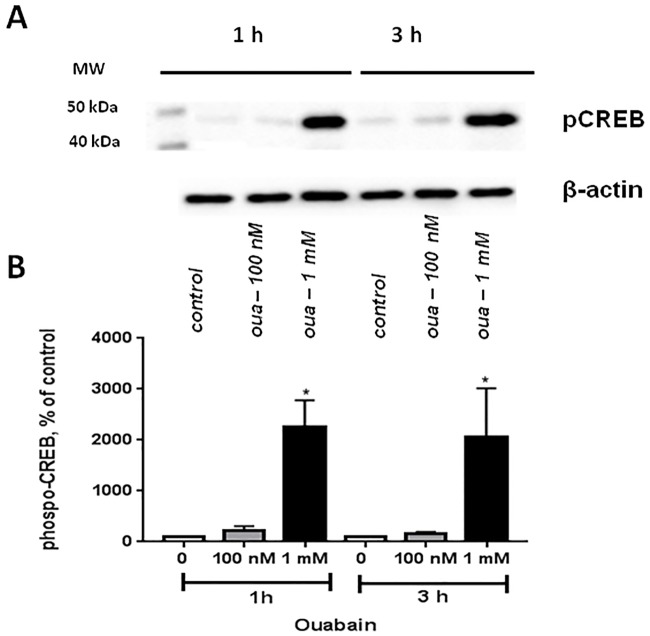
Effect of ouabain (oua) on CREB phosphorylation in cerebellum granule cells.A representative Western blot (A) and means ± SD for 4 independent experiments (B) are shown. *–p<0.05 compared to control.